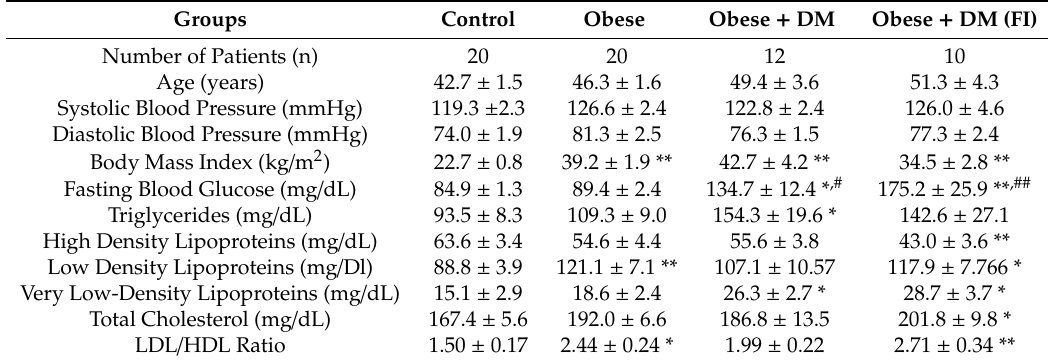
Table 1. Summary of BMI, fasting blood glucose and lipid profile in study subjects.